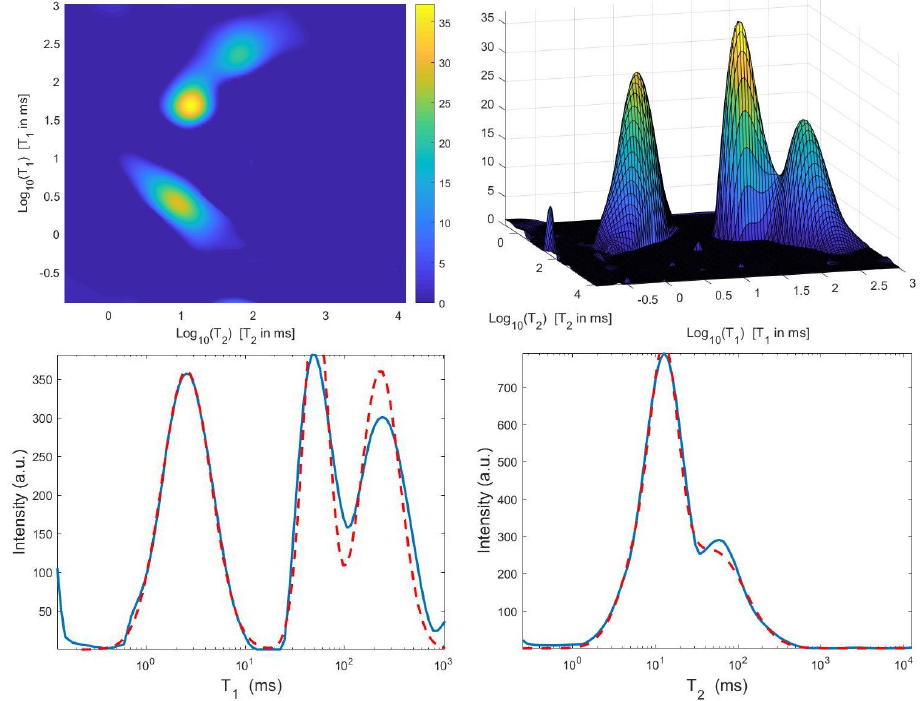
Figure 10. Hybrid method: restored T 1 – T 2 distribution and projections along the T1 and T2 dimen- sions ( τ =